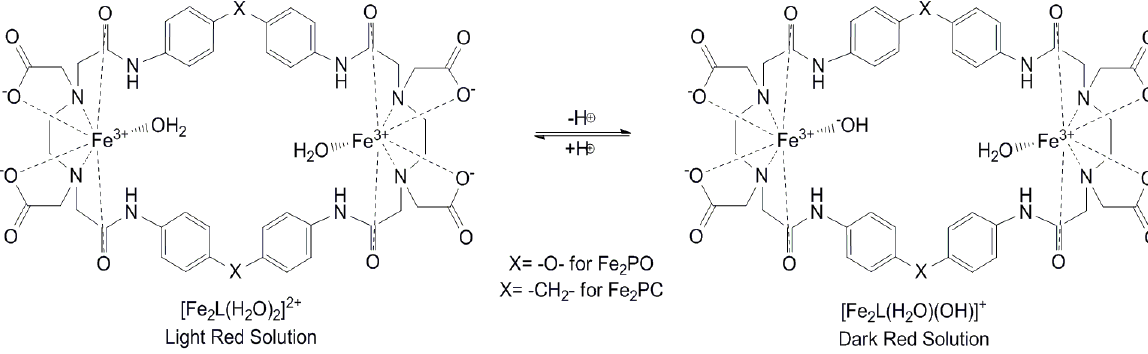
PO and Fe PC 2 2